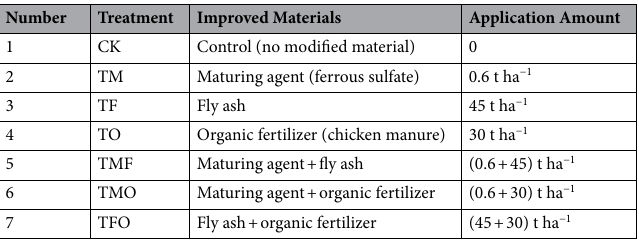
Table 4. Experimental design of reclamation soil improvement in hollow